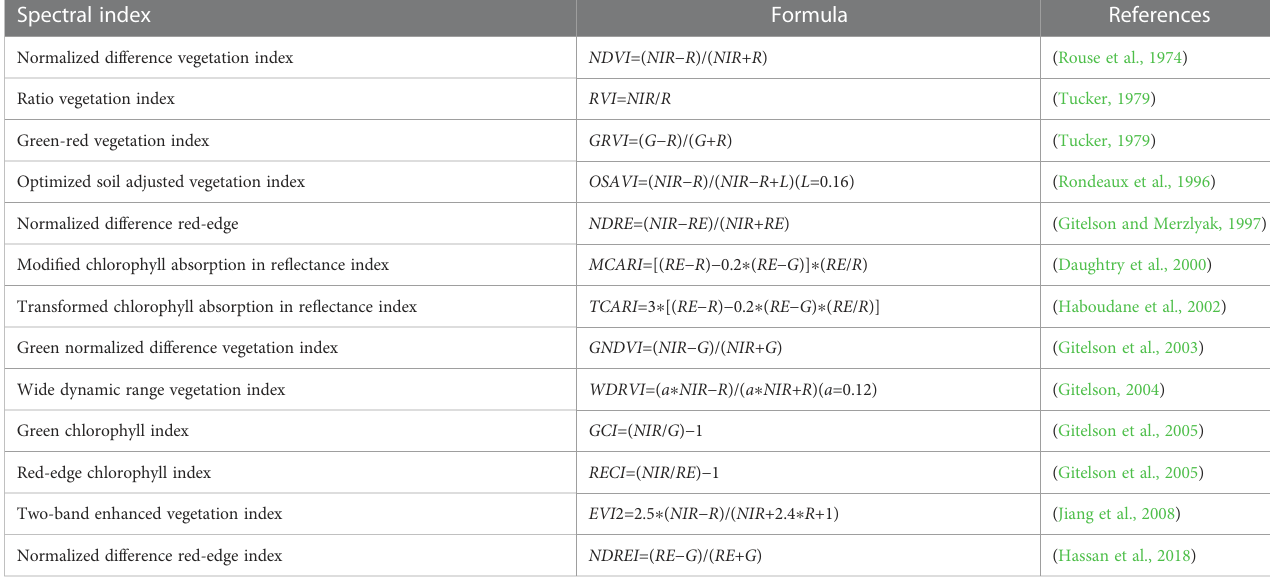
TABLE 2 De fi nitions of the features extracted from multispectral imagery. Spectral